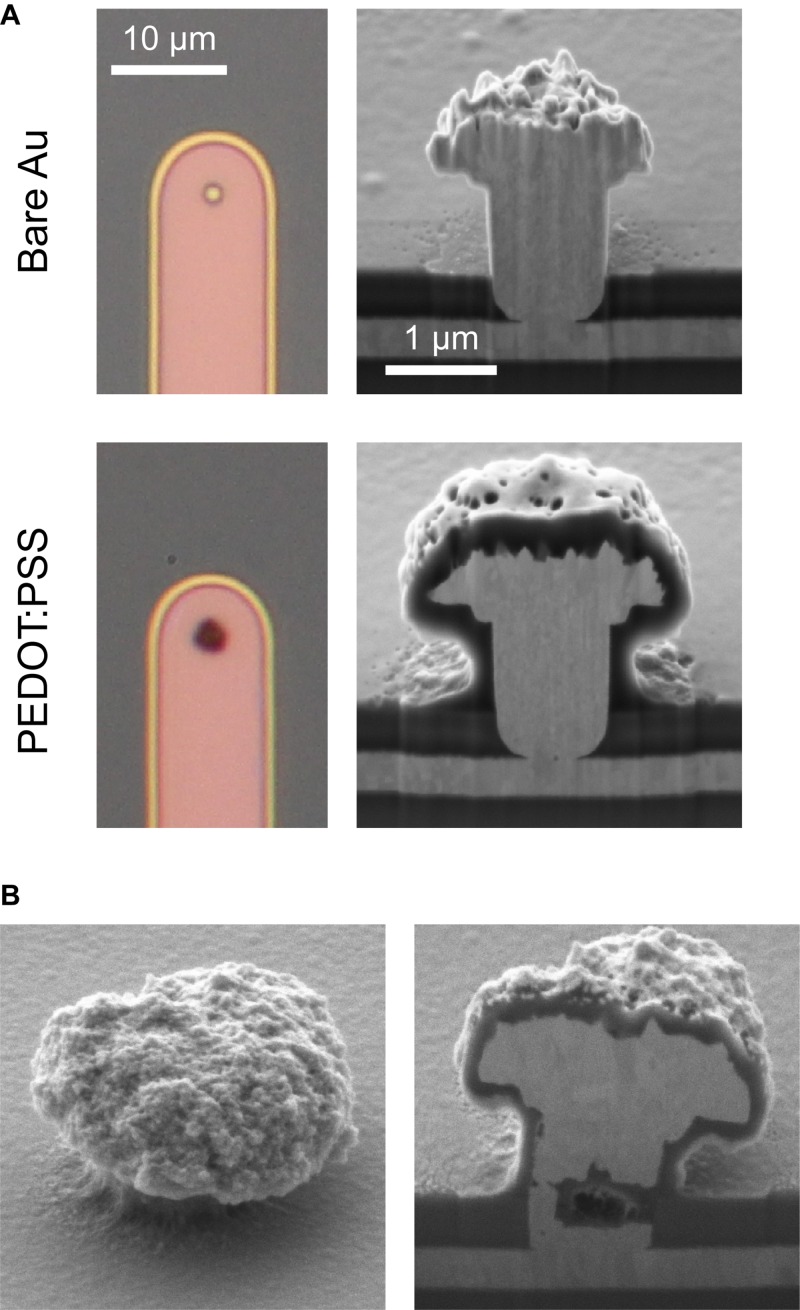
Optical and electron microscopy. (A) Optical micrographs (left) and SEM of FIB cross-sections of bare (above) and PEDOT:PSS-coated (below) gold ultramicroelectrodes. Electrodeposition of PEDOT:PSS produced a thin conformal layer. (B) Internal defects in an electrode were revealed by FIB cross-sections. Gold electroplating for this electrode used a current of −1.5 nA, in comparison to −0.4 nA for the electrodes in A. The scale bars in A apply to other optical and SEM images, respectively.